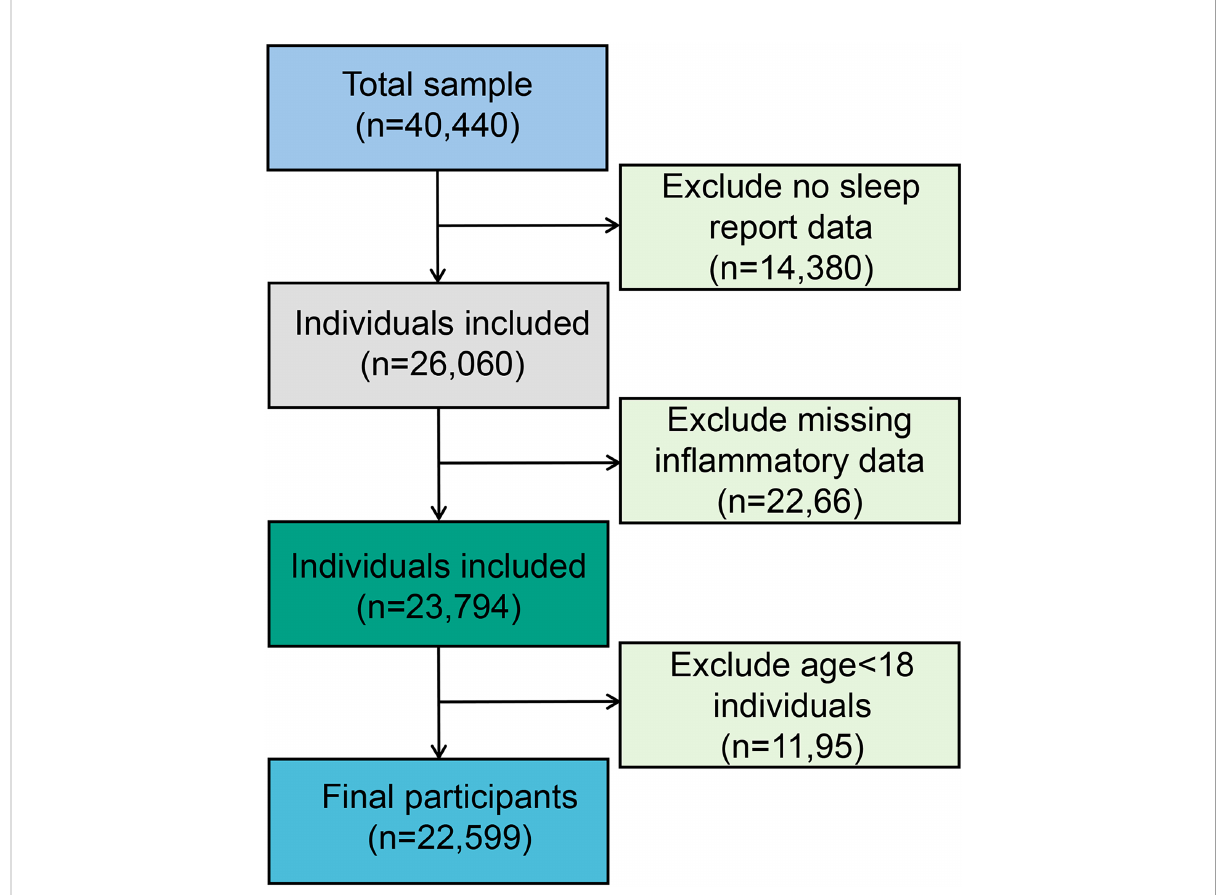
FIGURE 1 Flowchart of the study design and participants excluded from the